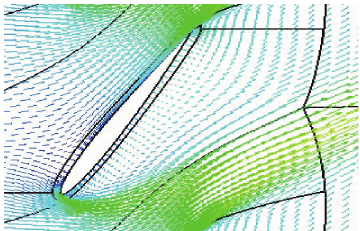
Figure 9: The change of efficiency with the setting angles.